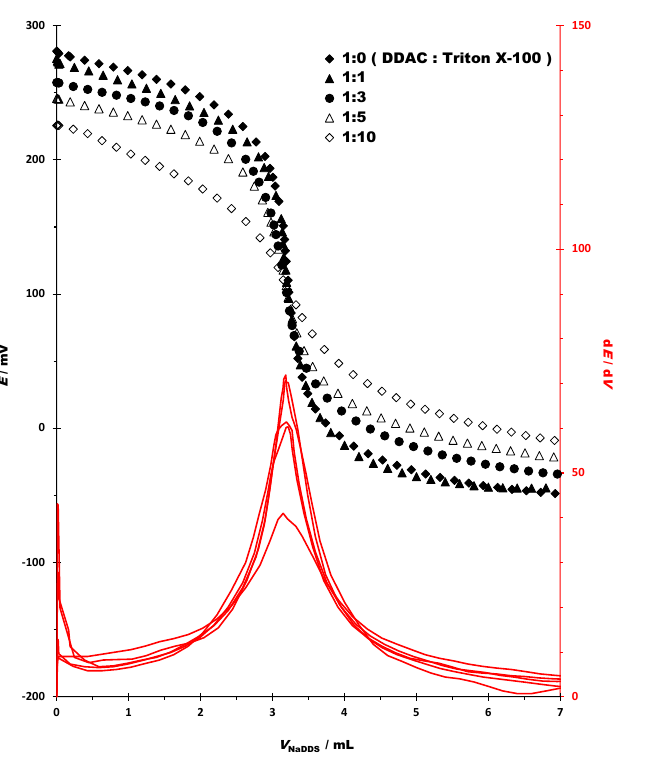
Figure 4. Potentiometric titration curves and their first derivatives of the model mixtures of DDAC and nonionic surfactant Triton X-100 in different proportions ( w / w ), using NaDDS as titrant ( c = 4 × 10 −3 mol/L) and DODI - TPB as a potentiometric sensor.